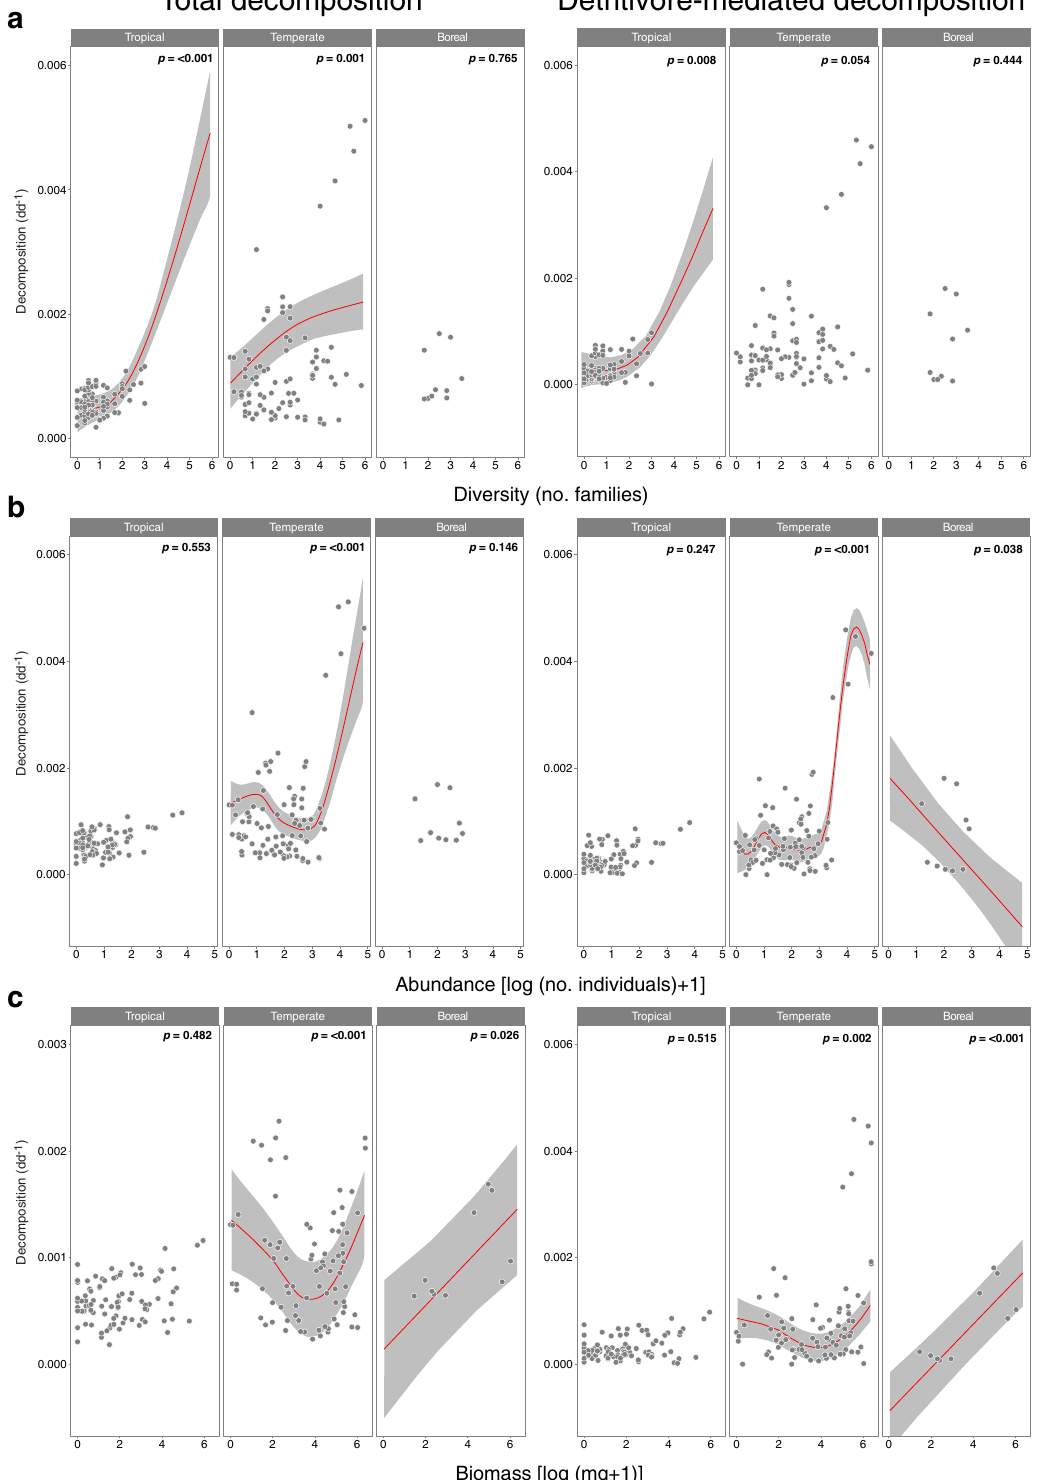
Fig. 1 Generalised additive models exploring the in fl uence of detritivore diversity, abundance and biomass on decomposition in different latitudinal zones (tropical: ≤ 23°; temperate: 24 – 60°; and boreal: >60°). Variation in total and detritivore-mediated decomposition (measured as the proportion of litter mass loss per degree day, dd; mean ± SE) with a detritivore diversity (number of families per litterbag), b log-transformed abundance (number of individuals per litterbag) and c log-transformed biomass (mg per litterbag), in different latitudinal zones. Lines represent the smoothers and shading the 95% con fi dence intervals from generalised additive models for signi fi cant relationships ( p- value < 0.05); whole-model results are given in Supplementary Table